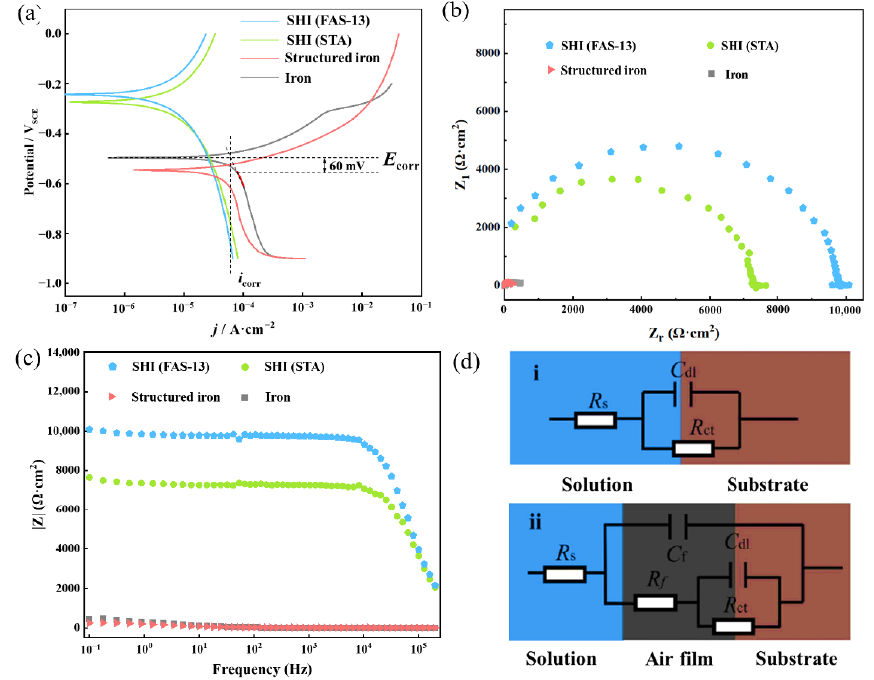
Figure 7. ( a ) PDP curves ( b ) Nyquist plot and ( c ) Bode plot measurements of ordinary iron, struc- tured iron, SHI (STA) and SHI (FAS-13) in 3.5% NaCl solution. ( d ) Equivalent circuit EIS results for ( i ) ordinary iron, ( ii ) structured iron, SHI (STA) and SHI (FAS-13) samples.